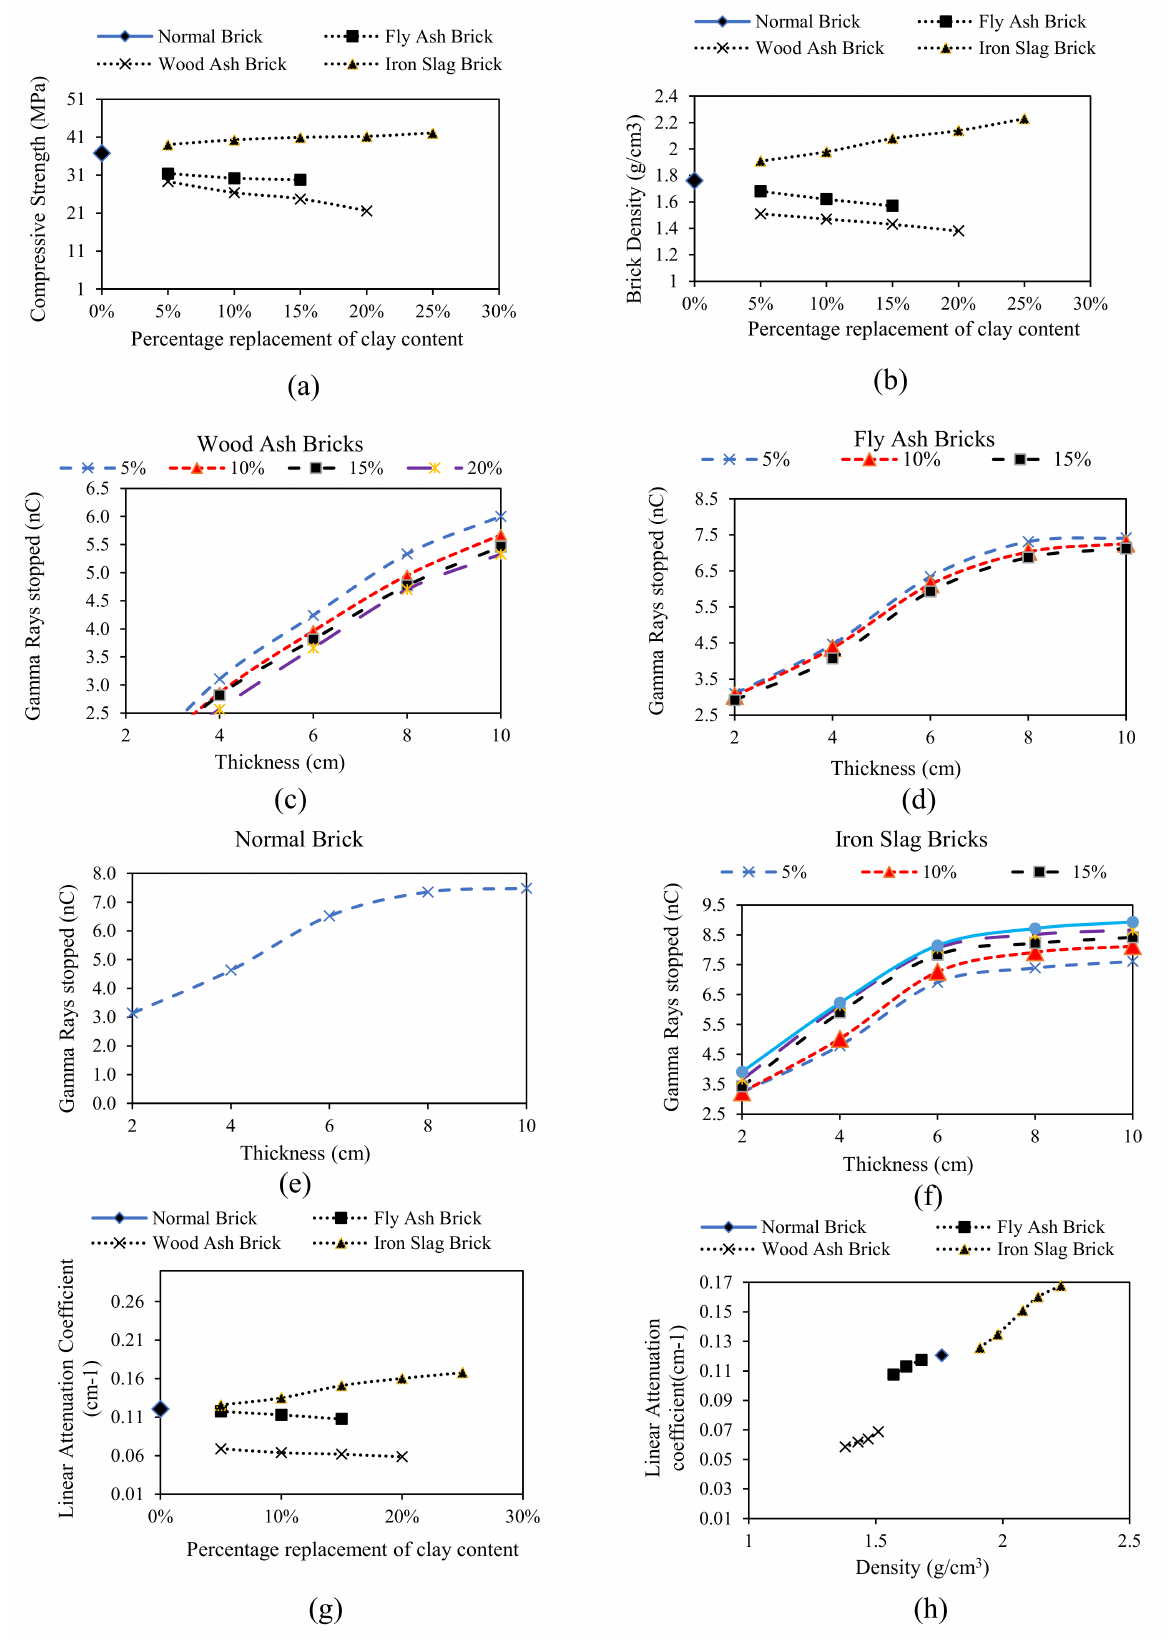
Figure 6. Experimental test